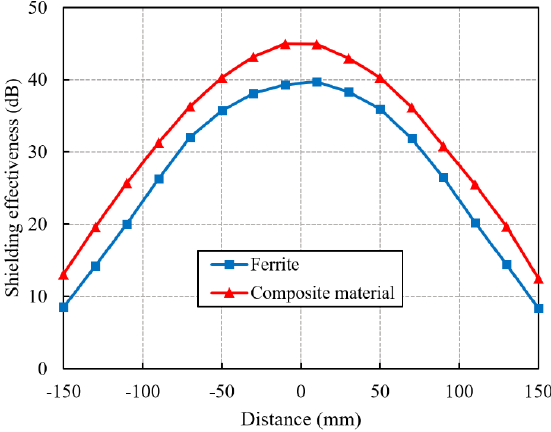
Figure 13. Shielding effectiveness at the measurement line.